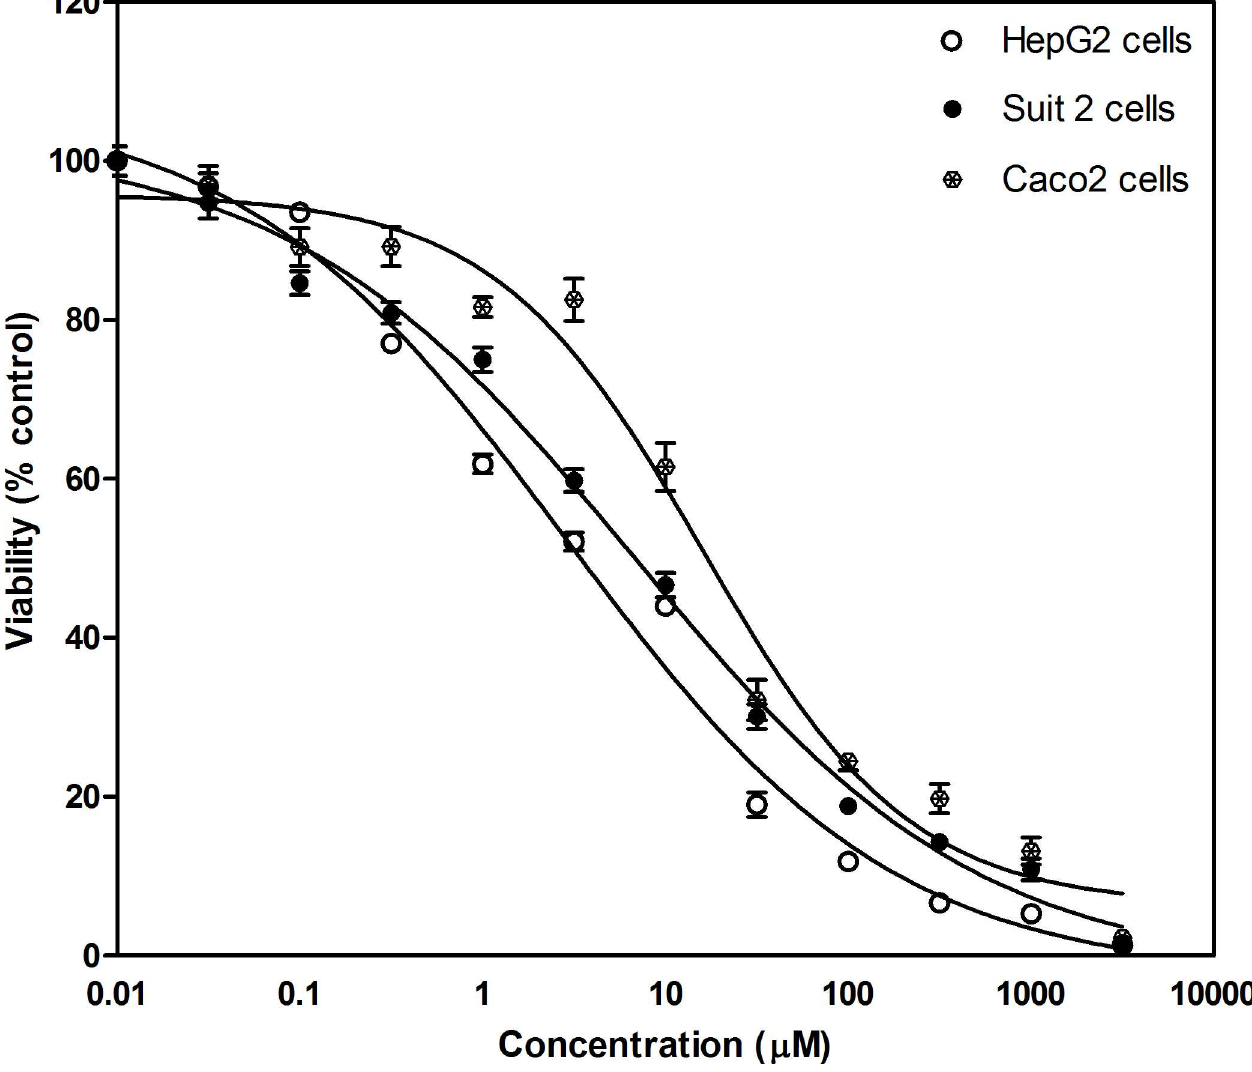
Fig 1. Fsitein inhibits growth of HepG-2, Caco-2 and Suit-2 cells. Exponentiallygrowingcells were cultured and treated with fisetin for 2 days. The SRB assay was then performed to assess cell viabilityand proliferation. Results are represented as mean value (M) ± S.E.M. of at least 3 independentexperiments (8 replica